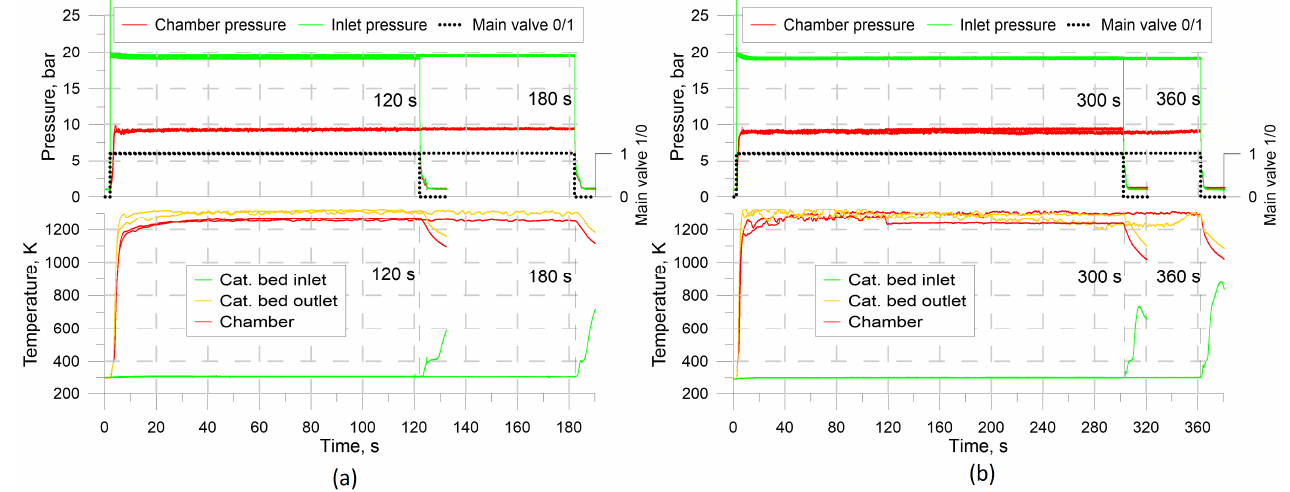
Figure 11. Steady-state characteristics of the catalyst bed: ( a ) 2 min and 3 min tests; ( b ) 5 min and 6 min tests.